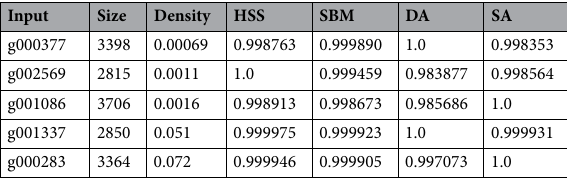
Table 4. Results for medium and sparse classes, same as Table